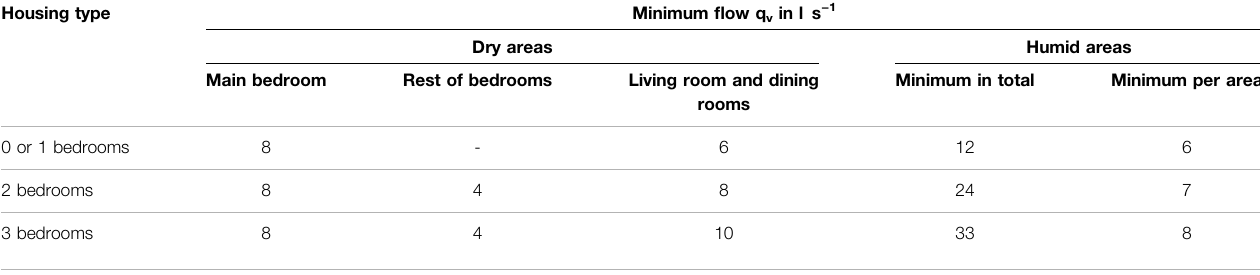
TABLE 3 | Minimum fl ow rate for constant fl ow ventilation in rooms. Source: CTE HS 3 (Gobierno de España, Ministerio de Fomento, 2019).